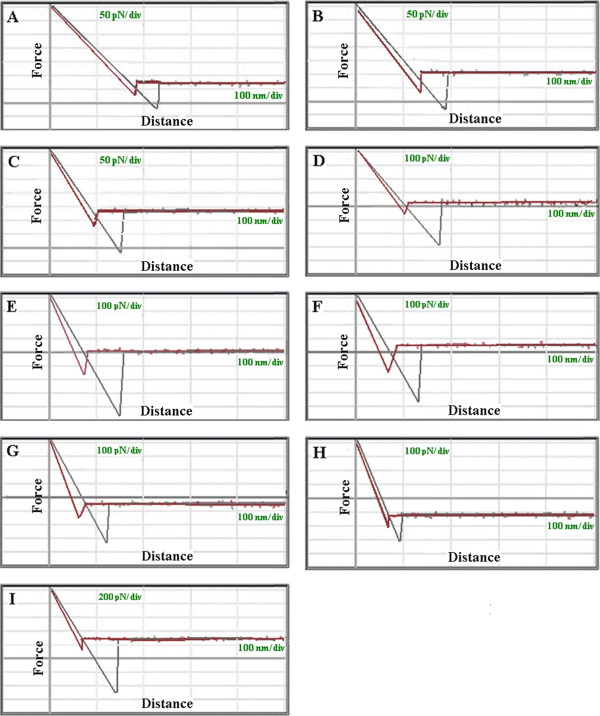
Representative force-distance curves. Longitudinal axis indicates force; horizontal axis indicates distance. (A) Force curve of ADS. (B) Force curve of 3DD. (C) Force curve of 6DD. (D) Force curve of 9DD. (E) Force curve of 12DD. (F) Force curve of 15DD. (G) Force curve of 18DD. (H) Force curve of 21DD. (I) Force curve of NC.